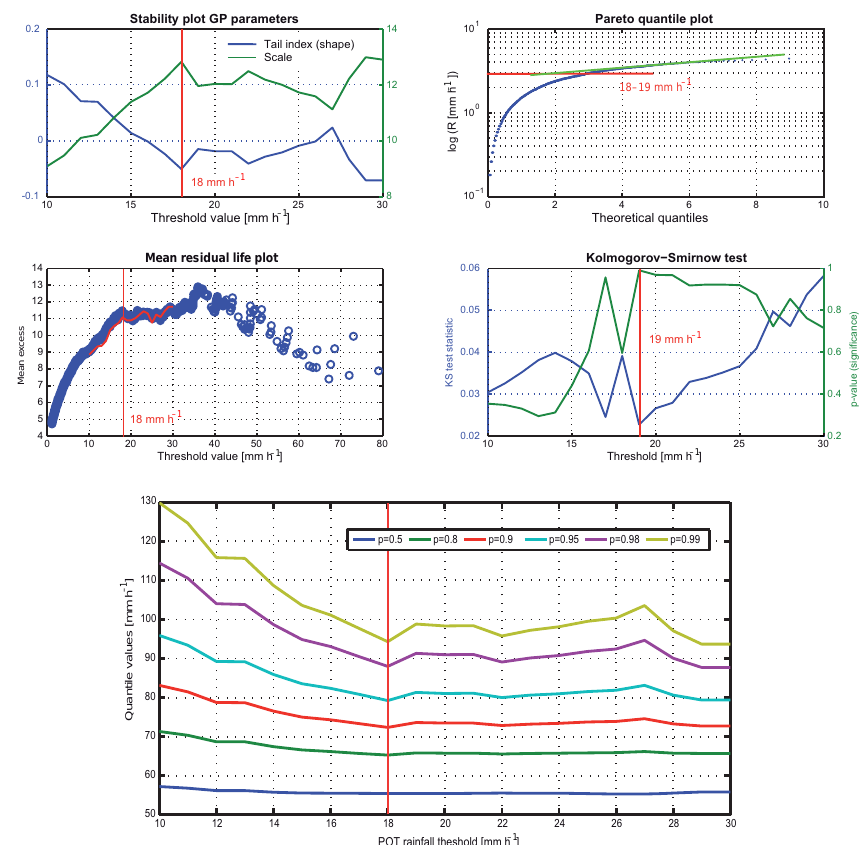
Figure 8. Threshold determination for the POT rainfall frequency analysis. Upper panel: analytical tests. For the Kolmogorov–Smirnov test the lowest KS statistic and the highest significance indicates the threshold. For the other tests the threshold is approximated by the point where trajectories deviate from an approximate linear behaviour. The red lines indicate the threshold determined by the individual tests. Lower panel: empirical test. Quantiles ( p = annual probability of non-exceedance) estimated with a maximum likelihood fitted generalized Pareto distribution and different POT thresholds. The red line indicates the threshold above which the estimated quantiles are approximately